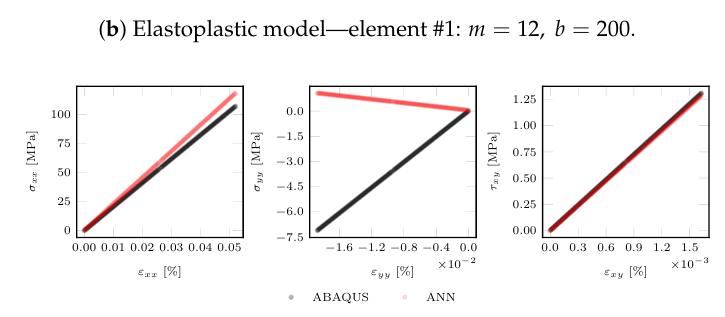
( c ) Elastic model—element #9: m = 12, b = 100.